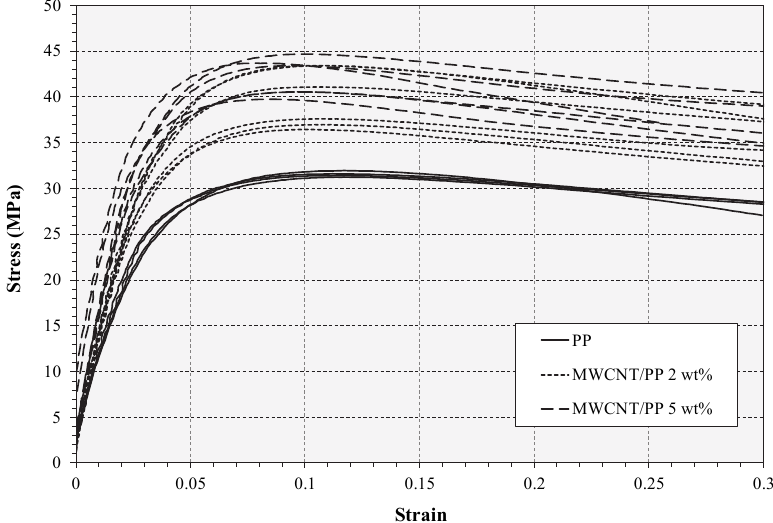
Figure 1: The stress-strain curves measured by the ARAMIS system for all tests.